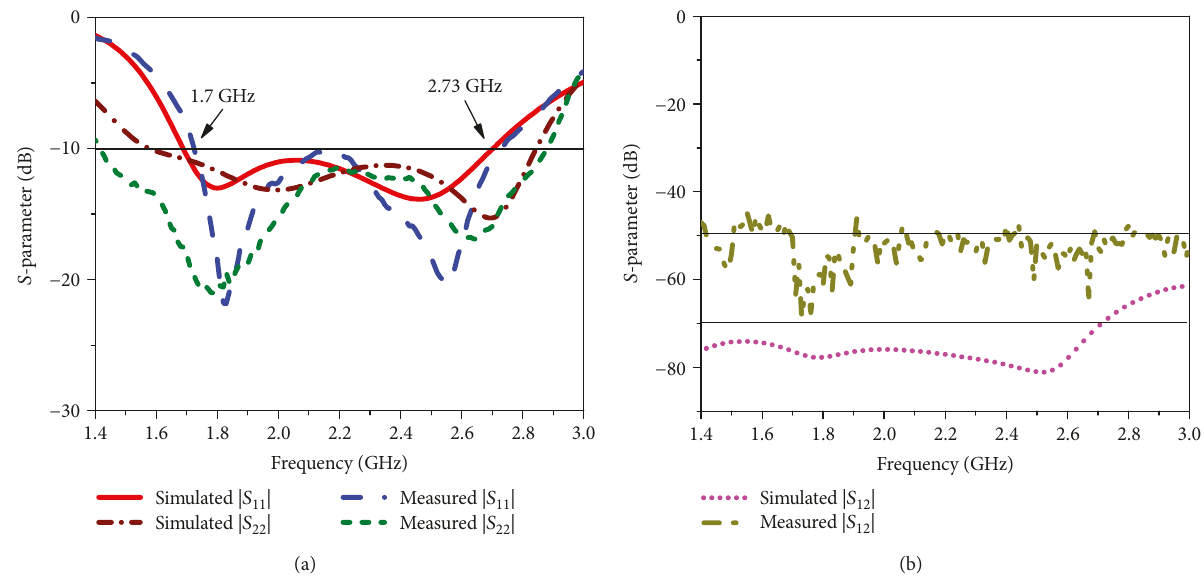
S S 11 and 22 and (b) 12